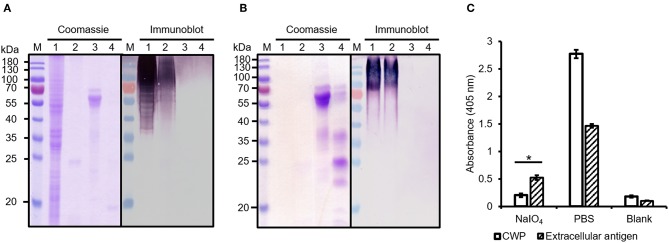
Analysis of protease-treated and periodate-treated Aspergillus antigens. (A) Cell wall proteins and (B) extracellular secreted antigens of A. flavus were extracted and digested with trypsin. Fractions were separated by SDS-PAGE and stained with Coomassie Brilliant Blue. Proteins transferred to a nitrocellulose membrane were detected with a purified mAb AP3 (400 ng/ml) and an AP-labeled goat anti-mouse antibody (120 ng/ml) followed by NBT/BCIP substrate incubation. M: Protein marker (Fermentas); Lane 1: sample without trypsin treatment; 2: sample with trypsin; 3: control protein fetuin without trypsin treatment; 4: control protein fetuin with trypsin. (C) Prepared A. flavus cell wall proteins (CWPs) and extracellular antigens (40 μg/well) were coated onto a microtiter plate and oxidized with periodate (80 mM). Untreated preparations were used as controls. After blocking free binding sites with 3% (w/v) skimmed milk, bound antigens were detected with mAb AP3 (400 ng/ml) and an HRP-labeled goat anti-mouse Fc antibody (120 ng/ml). Absorbance was measured in triplicate after 20 min substrate incubation. Values represents means ± SD (n = 3) for treated (NaIO4), untreated (PBS), and control (Blank). An asterisk denotes a statistically significant reduction in antigen binding between treated and untreated samples (CWF and extracellular antigen, p < 0.05).